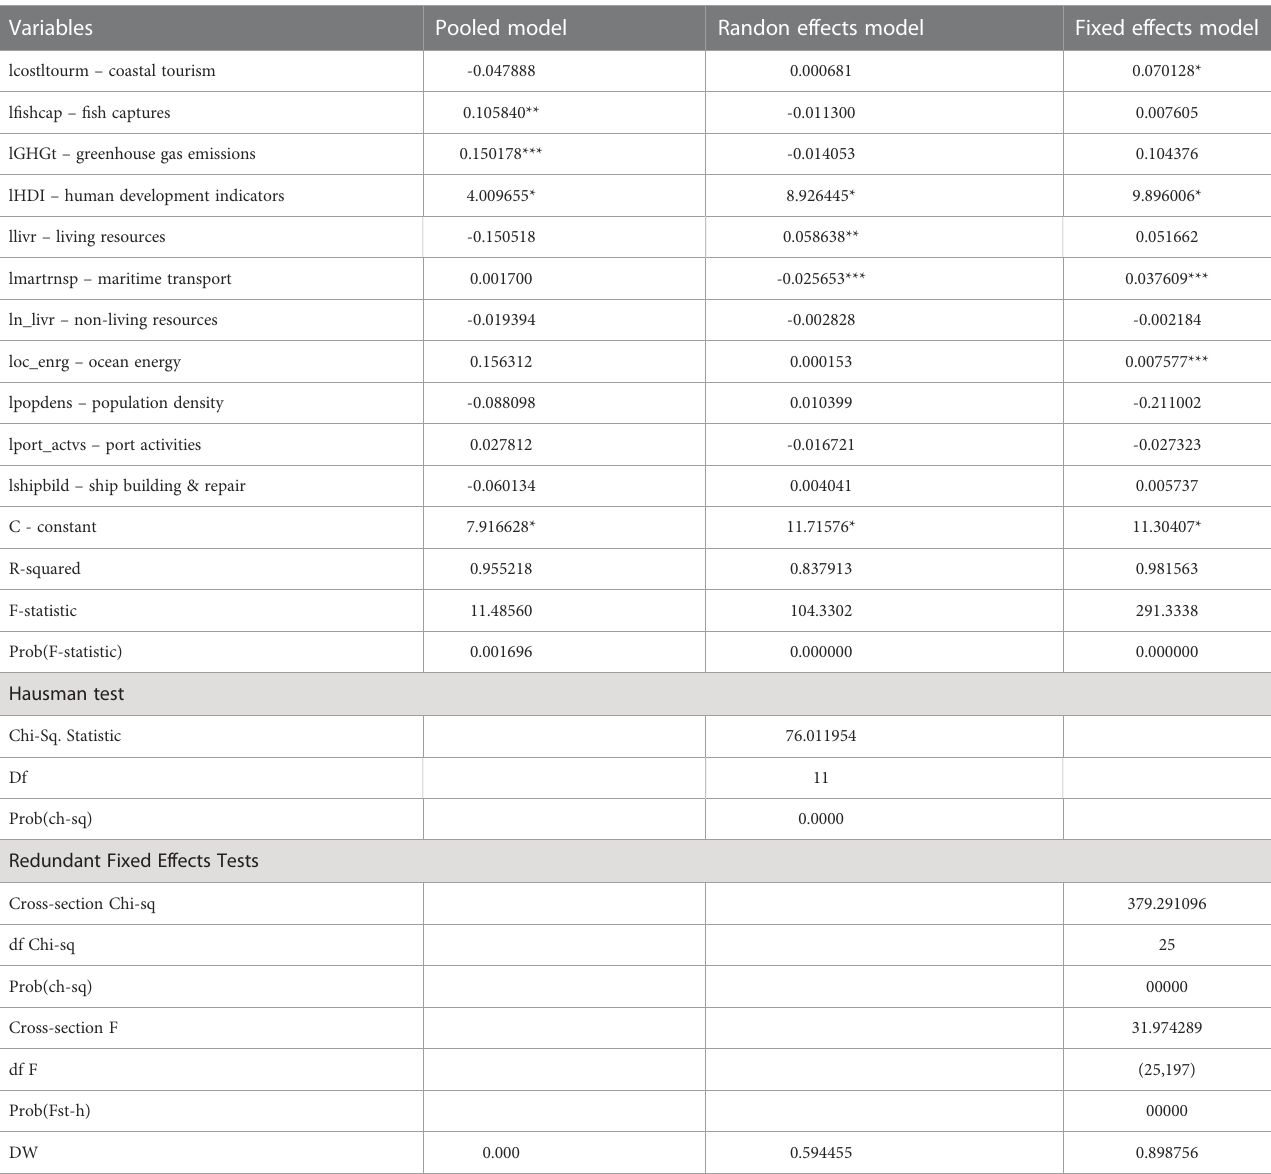
TABLE 3 Estimated panel data